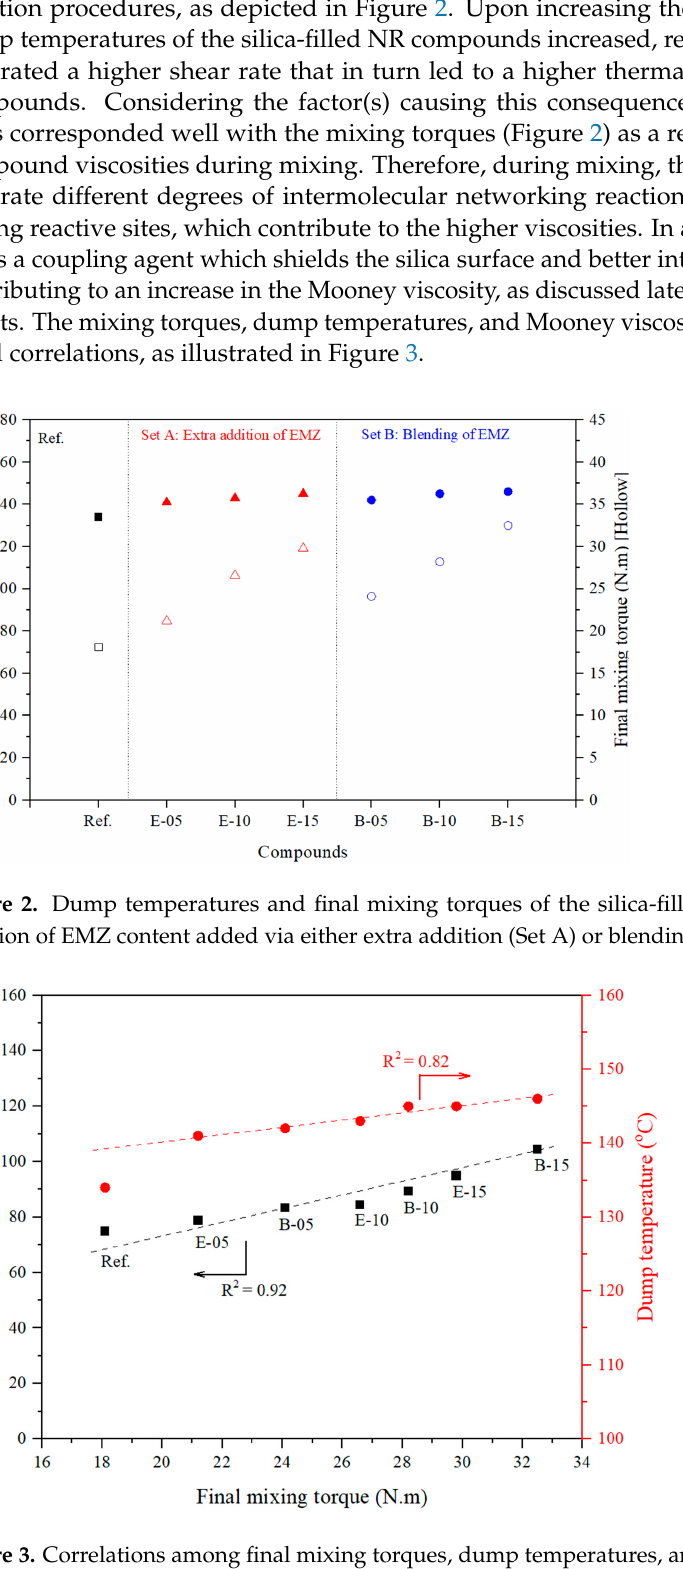
Figure 1. Mixing fingerprints based on ( a ) torque and ( b ) temperature of silica - filled NR com- pounds with various EMZ contents added via either extra addition (E05-E15) or blending (B05- B15).